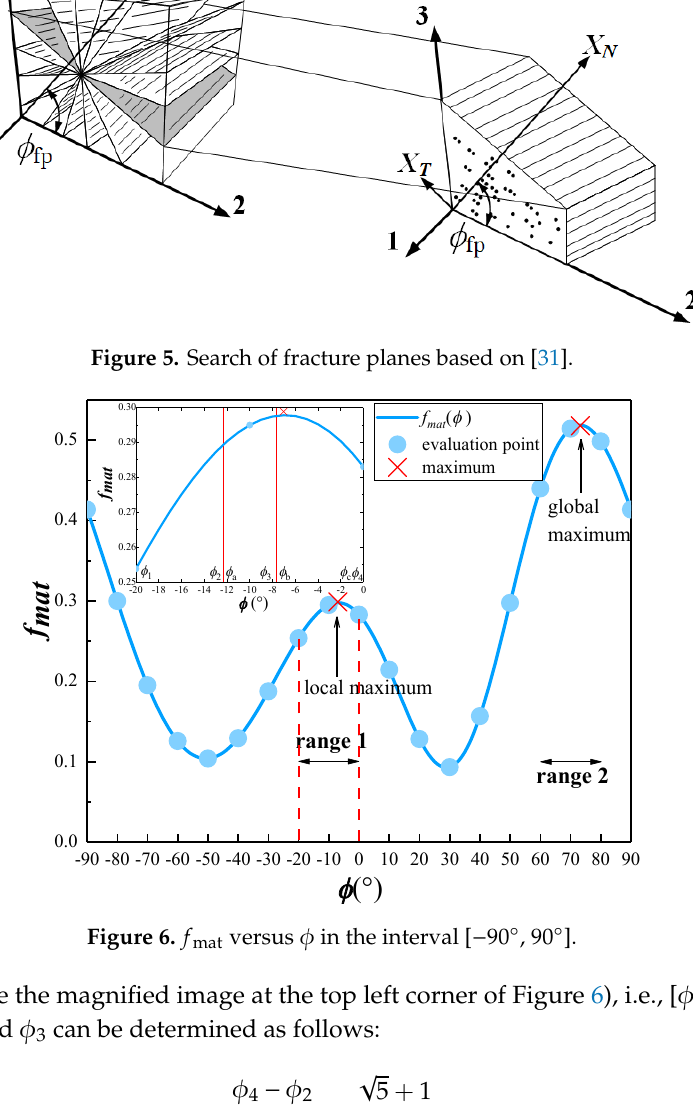
Figure 5. Search of fracture planes based on [31].